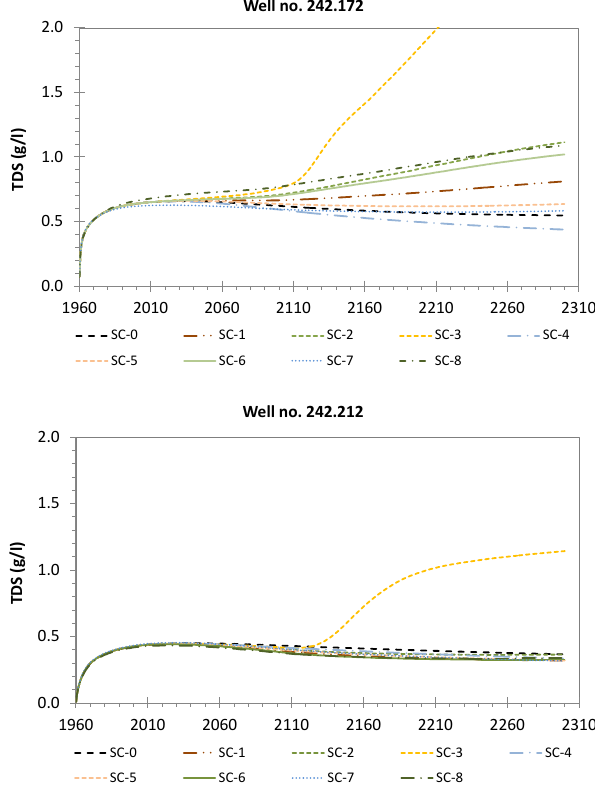
Fig. 11. Model simulation of TDS concentrations (gL − 1 ) in two groundwater abstraction wells for 9 scenarios (Table